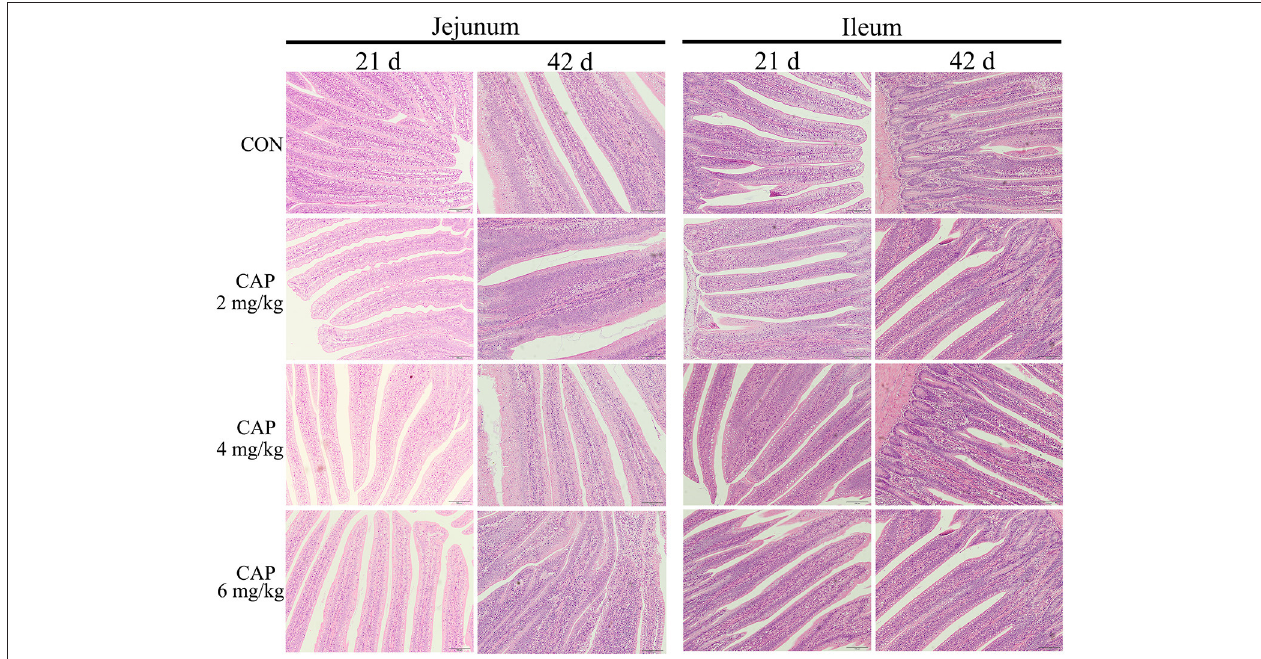
FIGURE 1 | The jejunum and ileum histological morphology of broilers (hematoxylin and eosin). CON, broilers were fed with a basal diet; CAP 2, CAP 4, and CAP 6 mg/kg, broilers were fed with a basal diet supplemented with 2, 4, and 6 mg/kg capsaicin, respectively. Scale bars = 100 µ m.